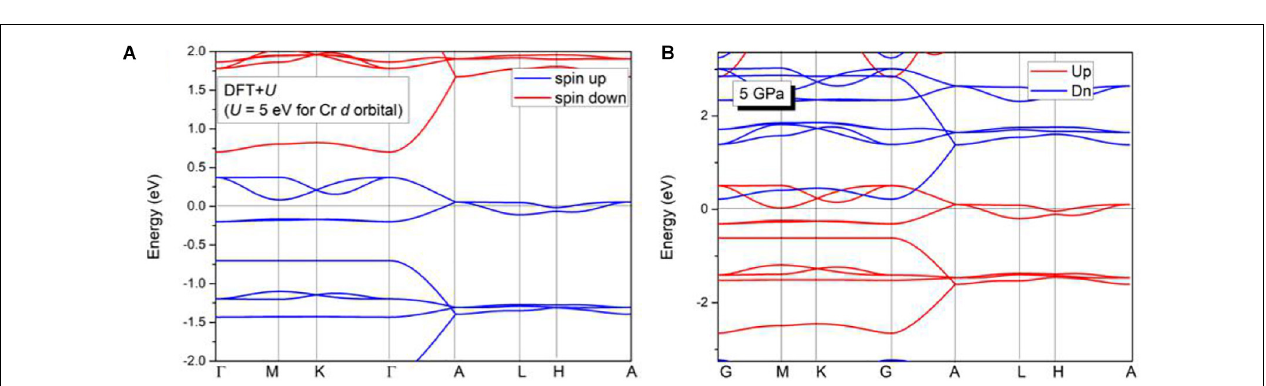
FIGURE 4 | Spin-polarized band structures of CsCrCl 3 system via DFT + U method. (A) for spin-up and (B) for spin-down.